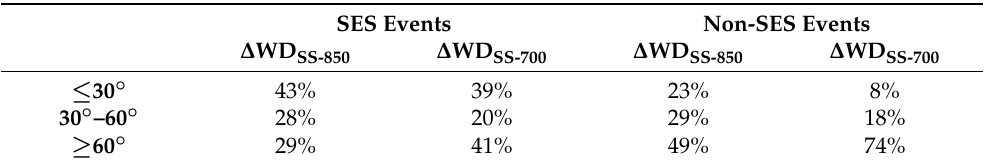
Table 3. Wind shear between the western Black Sea surface (point “B”) and upper atmospheric levels (850 and 700 hPa) in SES and non-SES